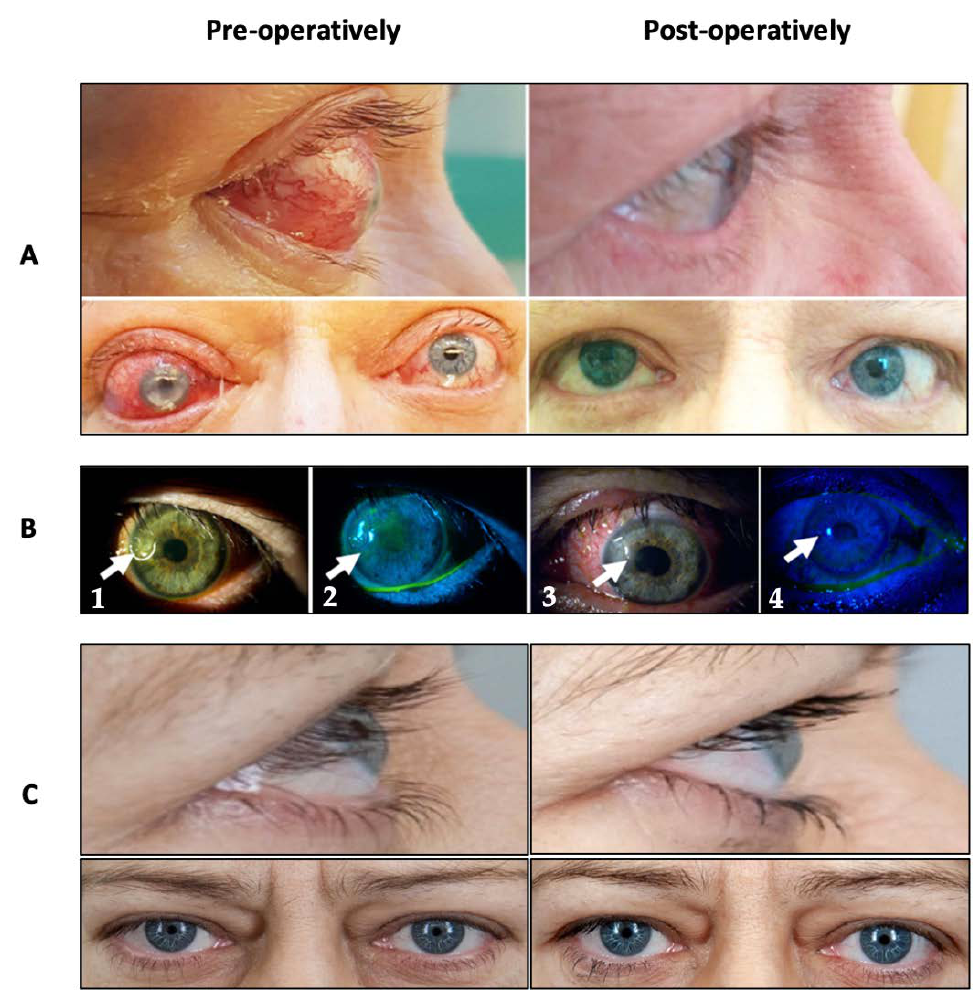
Figure 2. An ophthalmologic assessment of selected patients before and in the 3–12-month follow-up after TEOD. ( A ) The effect of treatment in a patient with exophthalmos and eyelid retraction. Patient still reports diplopia after 12 months after surgery. ( B ) The effect of treatment in a patient with corneal ulceration (arrows) before treatment (1,2) with ulceration and fluorescein binding at the site of ulceration, and after treatment (3,4) with no ulceration and no fluorescein binding at the site of the previous ulcer. Examination with diffuse illumination and 1% fluorescein with cobalt blue light at the slip lamp. ( C ) The effect of treatment in a patient with CON (right orbit).